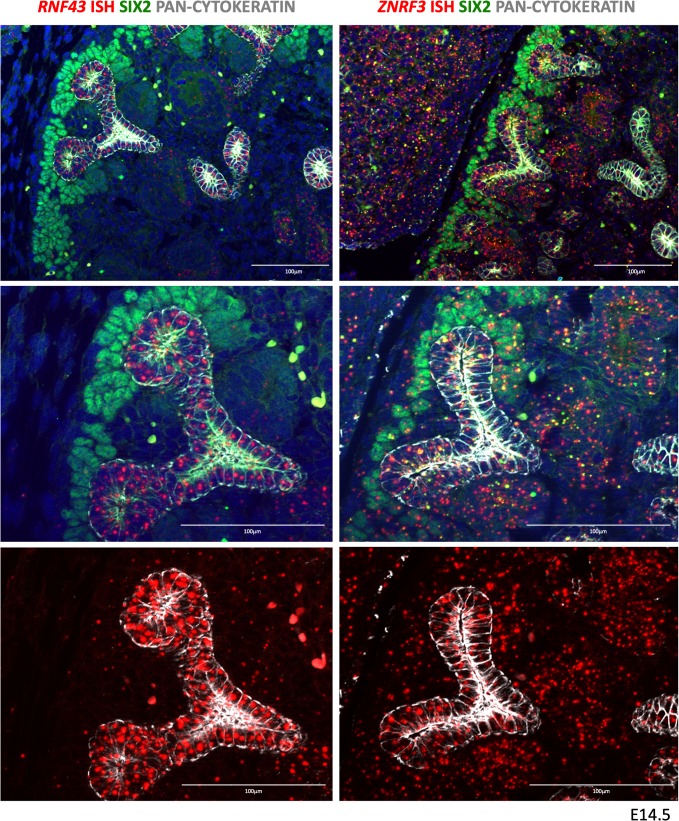
RNF43 and ZNRF3 expression pattern in developing kidneys.RNF43 expression was found to be strongly expressed in the developing collecting duct system, but very low/absent in other compartments. ZNRF3 expression was more widespread with signals visible in virtually all compartments.